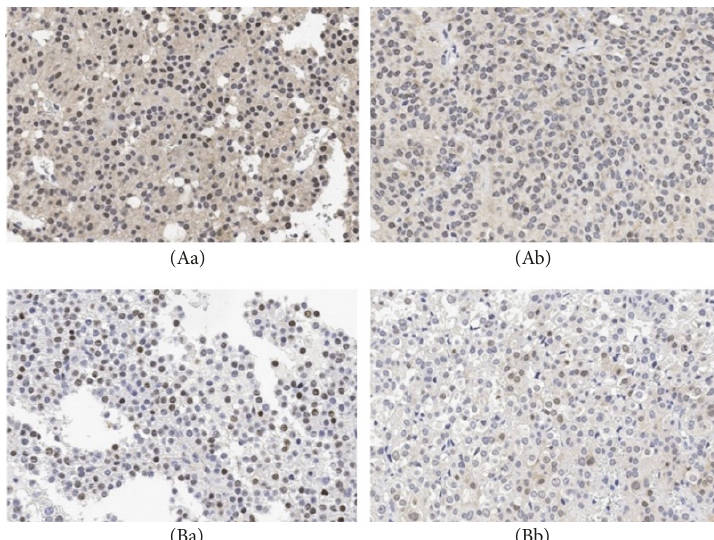
Figure 2: BTG2 and CDK2 expressed in each group. (Aa): BTG2 highly expressed in primary recurrent group; (Ab): BTG2 lowly expressed in nonrecurrent group. (Ba): CDK2 highly expressed in primary recurrent group; (Bb): CDK2 lowly expressed in nonrecurrent